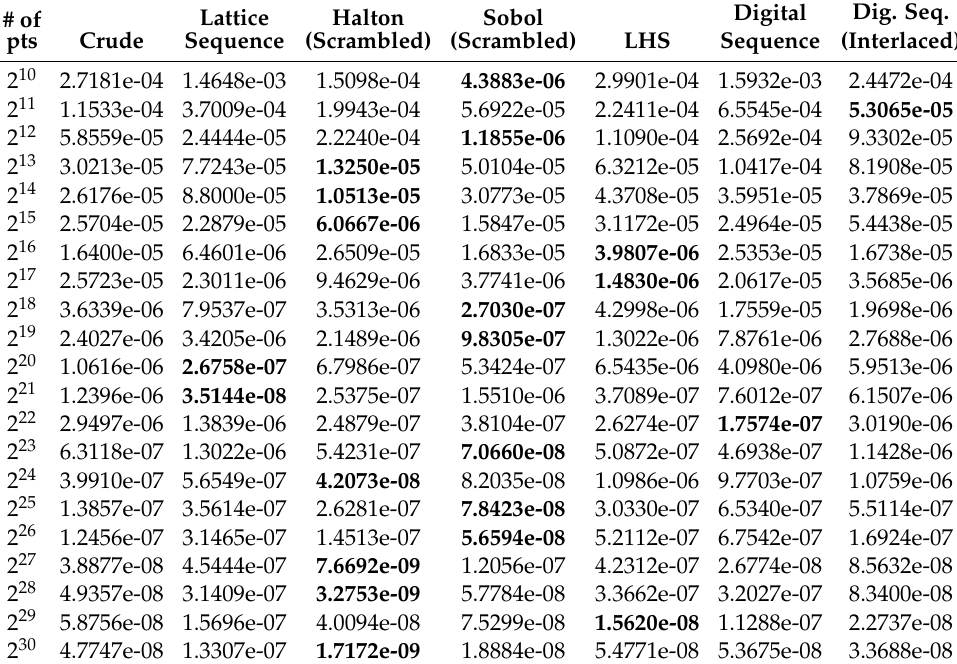
Table 4. The 40-dimensional integral absolute